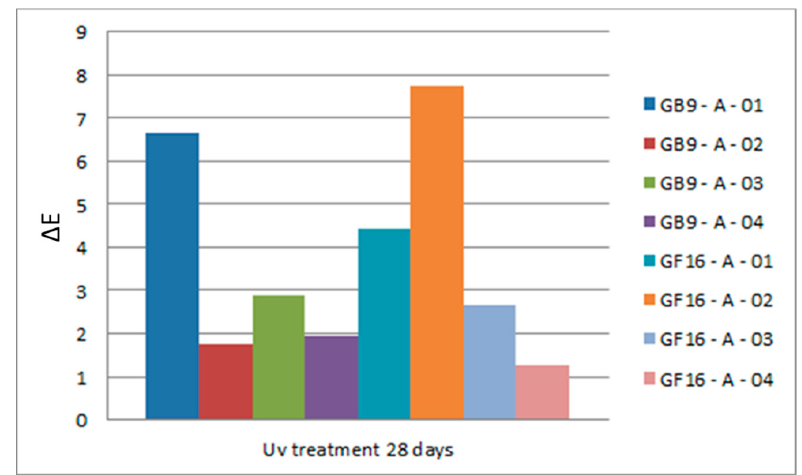
Figure 17. Average colour difference of limecolours with natural stabilizers after 28 days in UV radiation.